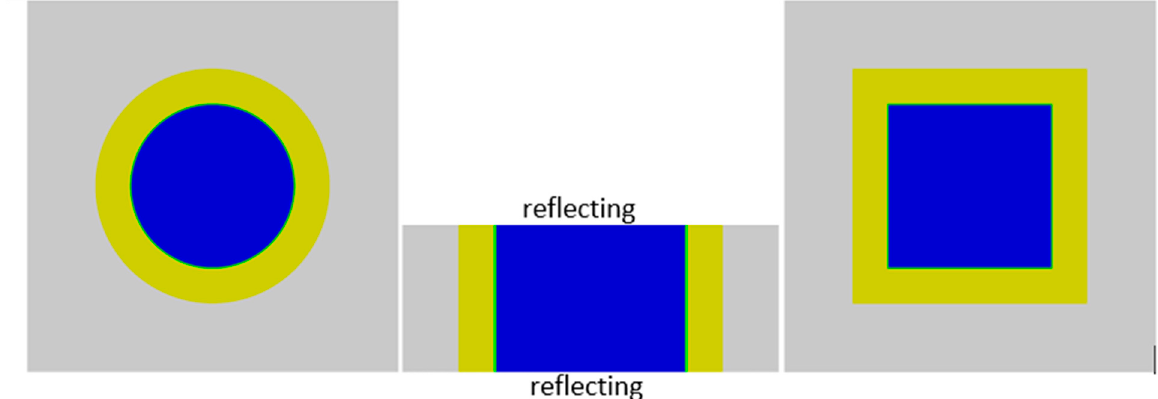
Figure 5. The general 2-D (left and centre) Monte-Carlo model of the configuration (left, top view x-y, centre front view x-z) and 3-D (left and right) Monte-Carlo model of the configuration (left, top view x-y, right front view x-z) with molten salt fuel core—blue, stainless steel vessel—light green, reflector—yellow, and vacuum—grey used for the validation of the results and the 3 ‐ D studies.